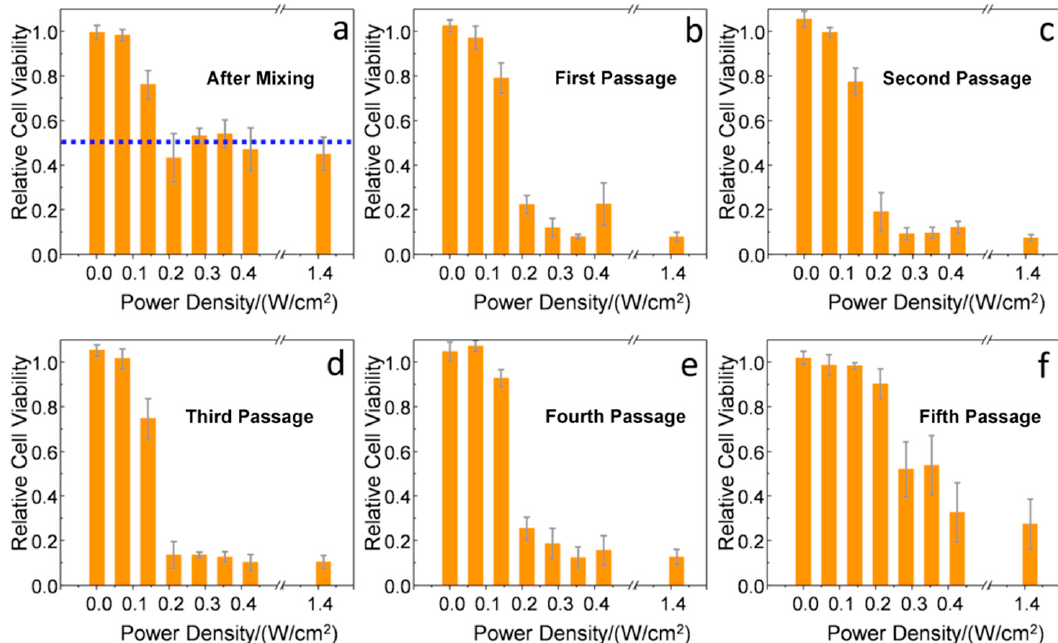
Figure 5. Cell viability as a function of the applied fs laser power density (3 independent samples were tested and averaged at each power density; the error bars show the standard deviation of the relative cell viability). ( a ) After mixing 50% of Au NS-loaded cells and 50% of non-loaded cells, we observed a killing rate of ca. 50% (see blue dashed line) using laser power densities above 0.21 W / cm 2 . After the first ( b ), second ( c ), third ( d ), and fourth ( e ) cell passage, the cell killing rate increased with small di ff erences (10–20%) in cell survival using a laser power density of at least 0.21 W / cm 2 . After the fifth passage ( f ), we did not observe important cell killing rates.